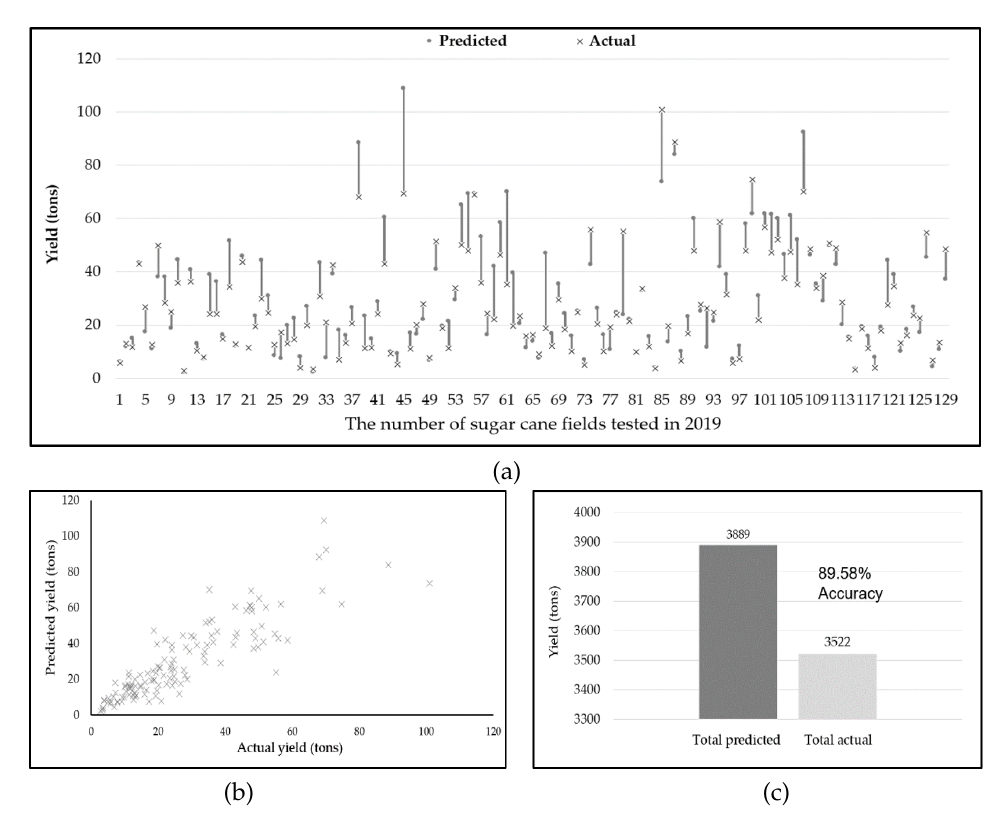
Figure 15. Test results when the finished model was run on Classified Data Subset B: ( a ) The difference between each predicted yield and actual yield is displayed as a line. ( b ) The correlation between predicted yield and actual yield. ( c ) Total predicted yield compared with total actual